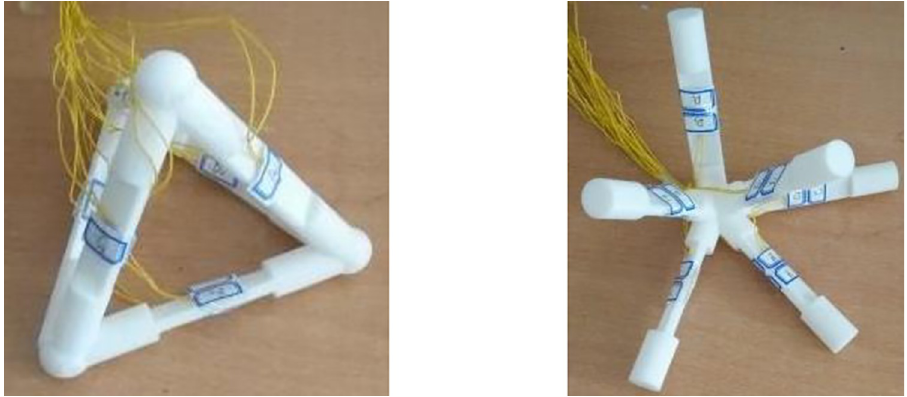
Fig 4. Application of line strain representation method—three-dimensional strain rosette. (a) Regular tetrahedron shape. (b) One point shape.